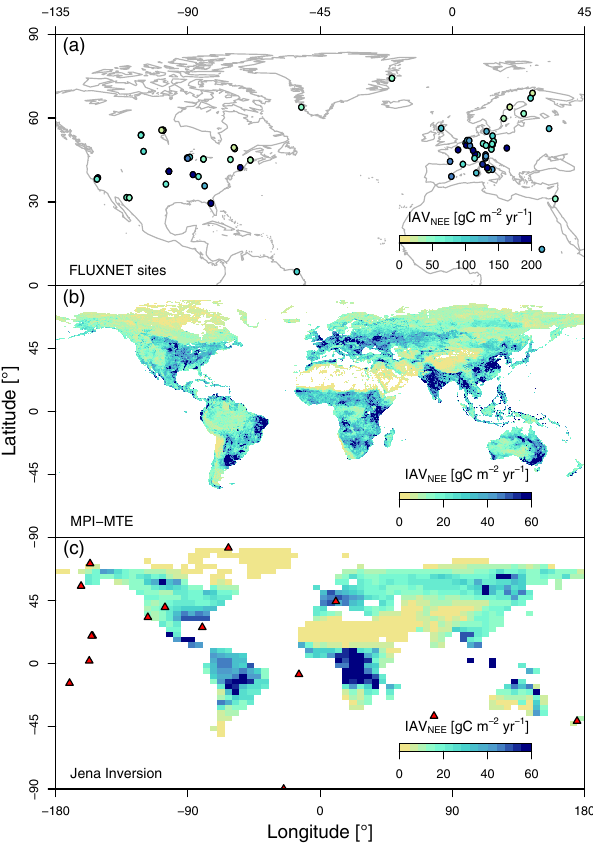
Figure 1. Spatial distribution of NEE standard deviation used as a measure of inter-annual variability (IAV NEE ). Results are shown for (a) FLUXNET sites with at least 5 years of observations, (b) the MPI-MTE NEE product and (c) the Jena Inversion prod- uct s81_v3.6; red triangles represent the CO 2 concentration mea- surement sites. Different scales were used for FLUXNET and the global product maps since the latter show a lower